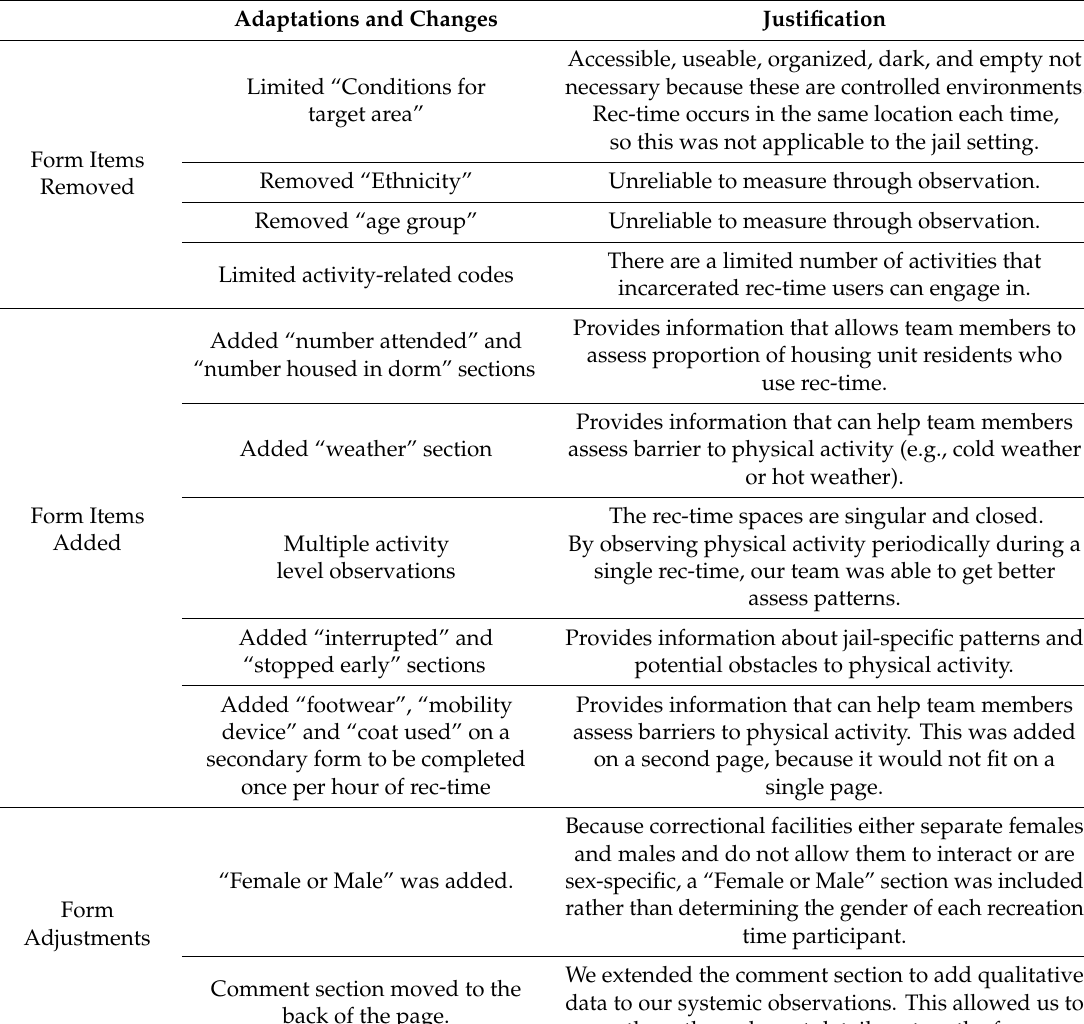
Table 1. Description of adaptations and changes from original System of Observing Play and Recreation in Communities (SOPARC) observation form for use in the correctional